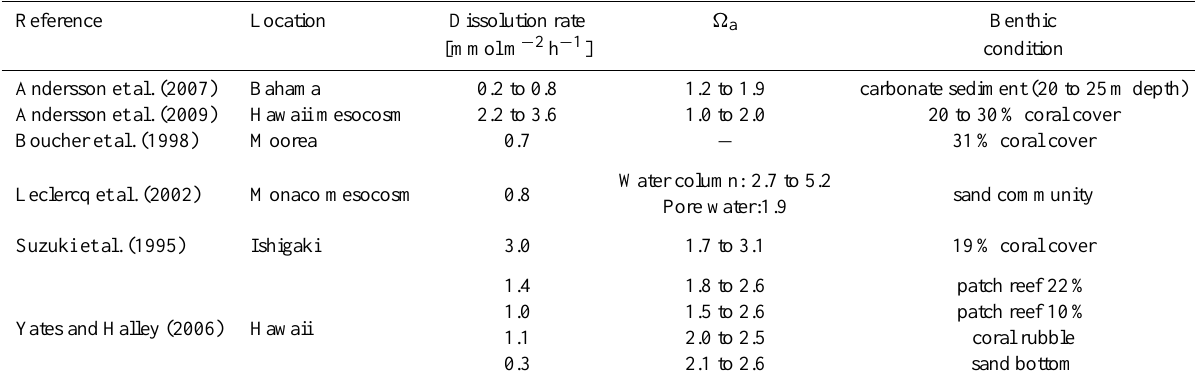
Table 3. Carbonate dissolution rates reported from carbonate environments and